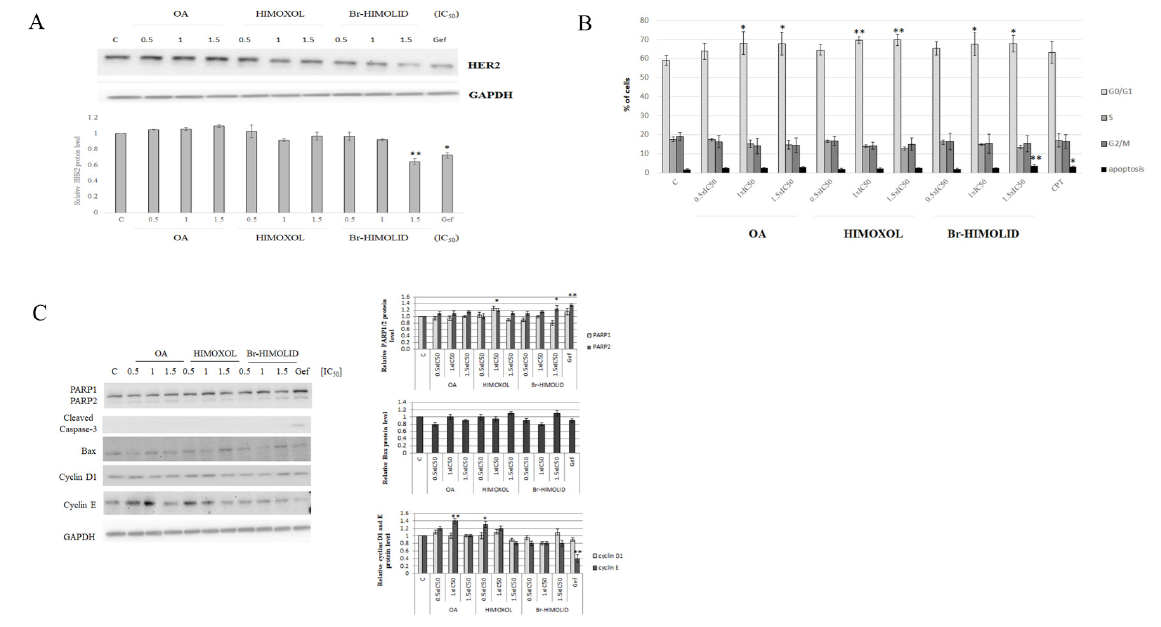
Figure 5. Evaluation of cell cycle modulation and proapoptotic potential of OA and its derivatives. SK-BR-3 cells were treated with studied compounds and 0.5 × , 1 × , or 1.5 × IC 50 values were applied followed by immunodetection. ( A ) Im- munoidentification of target proteins was subjected to densitometry analysis. ( B ), normalized to GAPDH. Gefitinib (Gef, 20 µ M) was used as a positive control. The mean value of three experiments ± SD is shown; p < 0.05. ( C ). Statistically significant difference versus control samples is shown: * p < 0.05; ** p < 0.005.